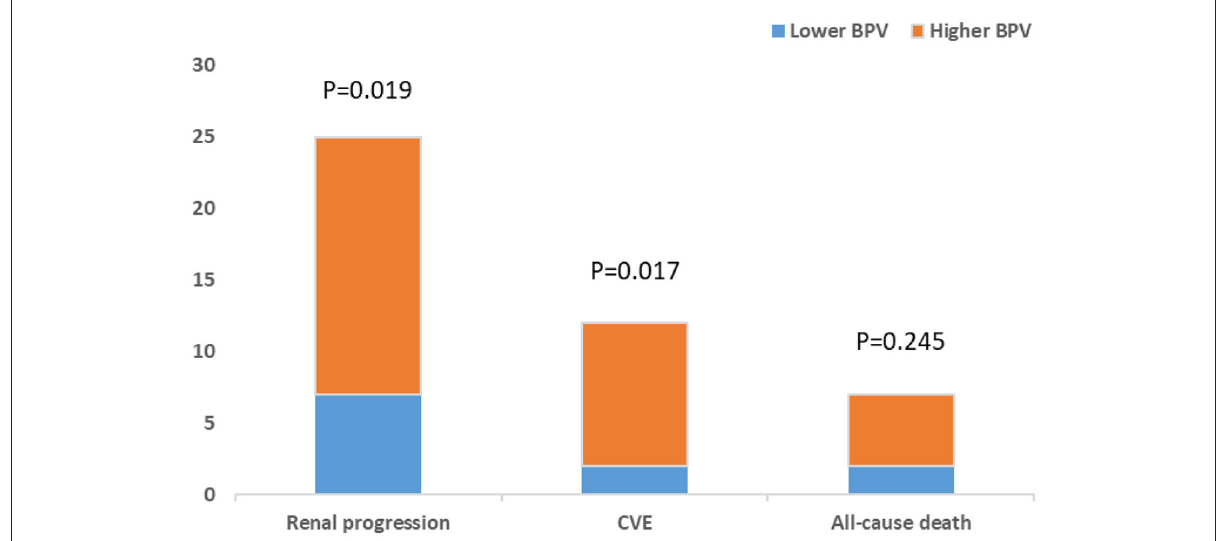
FIGURE2 Comparison of renal progression, cardiovascular events and all-cause death between higher BPV and lower BPV group.